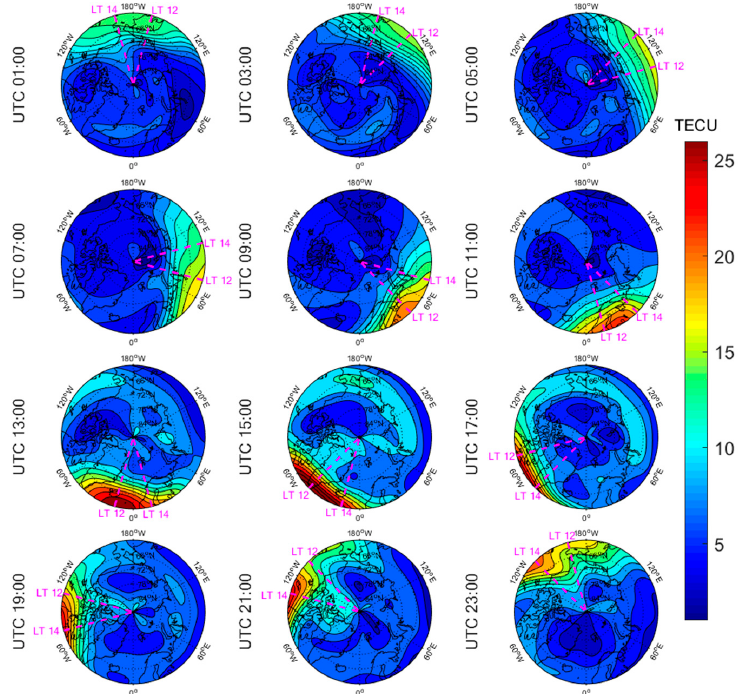
Figure 7. Spatial distribution of mapping TEC of 12 sections under high solar activity year, polar night (DOY 001 in 2014) over the Arctic. The magenta lines in each subplot represent the longitudes at 12:00 and 14:00 at the middle of the 2 h section of the corresponding subplot.